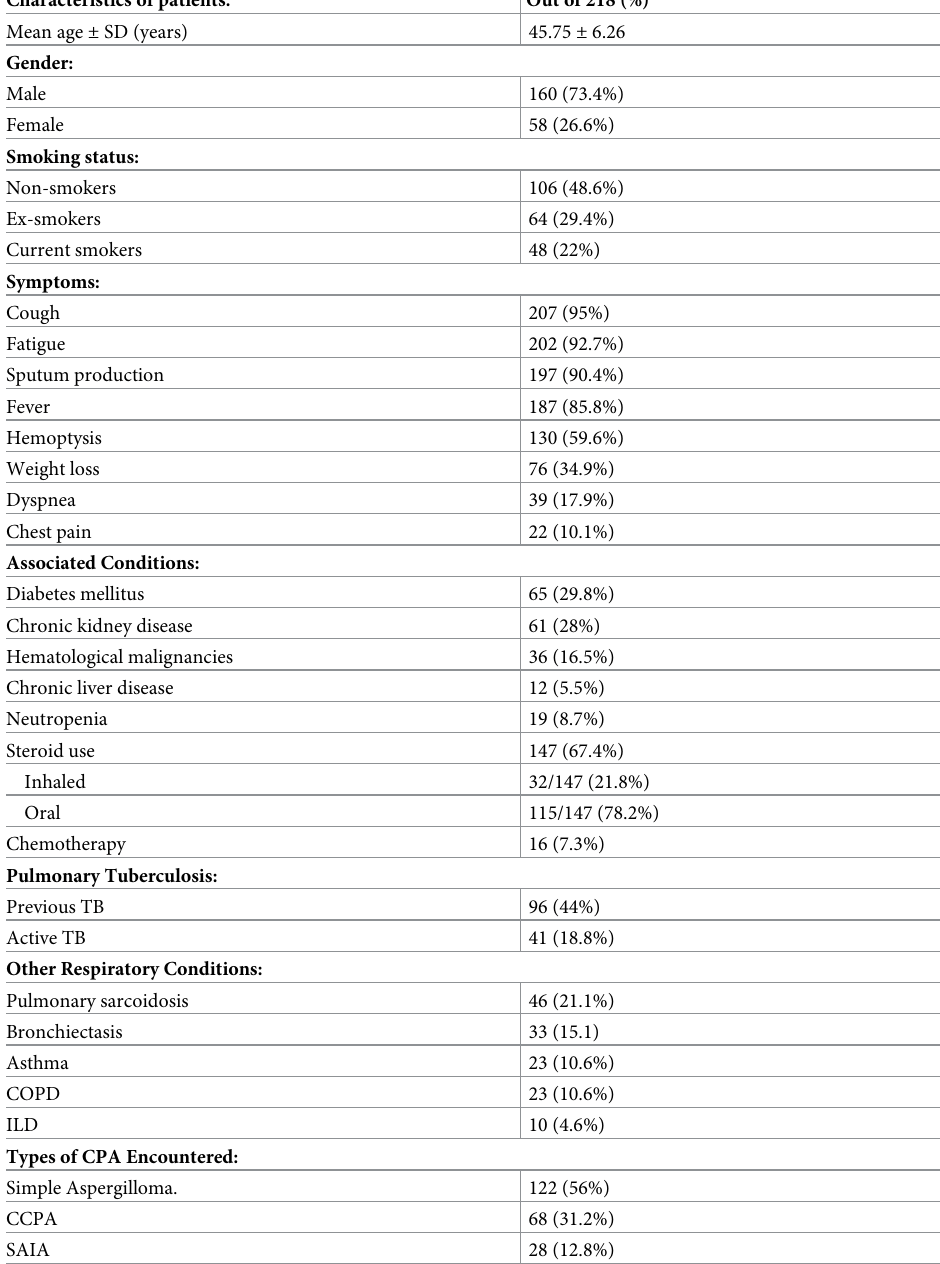
Table 1. Characteristics of patients with chronic pulmonary aspergillosis. Characteristics of patients. Out of 218 (%) Mean age ± SD (years) 45.75 ±